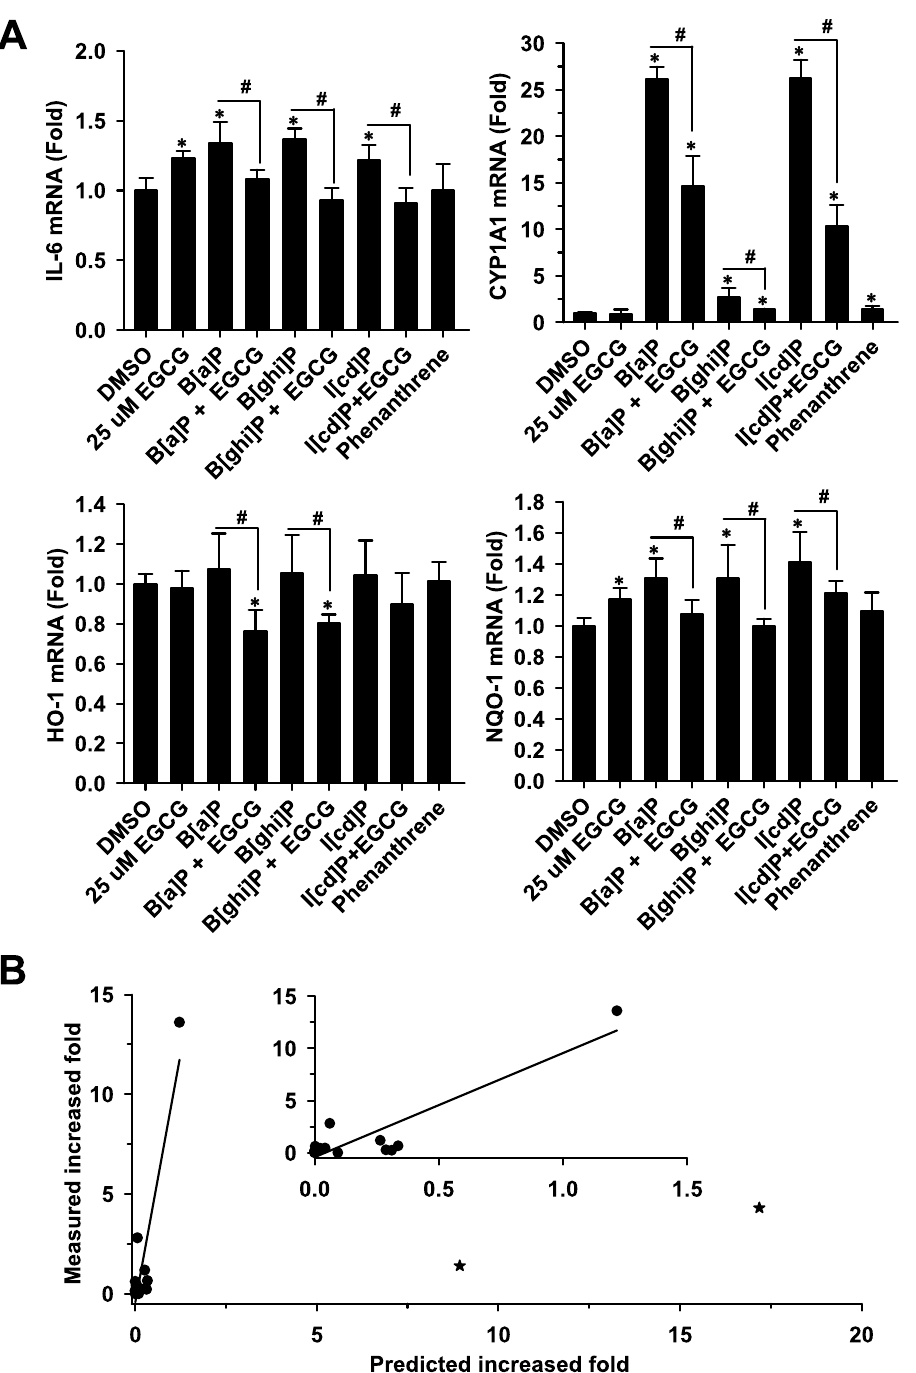
Figure 7. EGCG ameliorates the potent sub-toxic biomarkers induction by HMW-PAHs ( A ) and the significant correlation between predicted biomarker-induction through HMW-PAHs and the measured induction of biomarkers by the dichloromethane extracts (DEs) of truck exhausts ( B ). In panel ( A ), cells were exposed to PAHs (2 μM) alone or together with EGCG (25 μM) for 48 h. Data represent the means ± SD of three different experiments with duplicate determinations in each experiment. *, p < 0.05, compared to the control; # p < 0.05, compared to the DE of diesel-high exhaust (Student’s t -test). ( B ) There was a positive correlation between predicted and measured (experimental) increases in the mRNA levels of IL-6, CYP1A1, HO-1 and NQO-1 by the gasoline/diesel emissions under idle and high speeds. The correlation between measured and predicted increases were analyzed using the GraphPad Prism software (version 3.02, GraphPad Software, San Diego, CA, USA) as described in the Methods. The solid line shows the best fit of a positive correlation following the equation: measured value = A + B × (predicted value) (r = 0.904). A and B were − 0.424 and 9.97, respectively. ★ ,